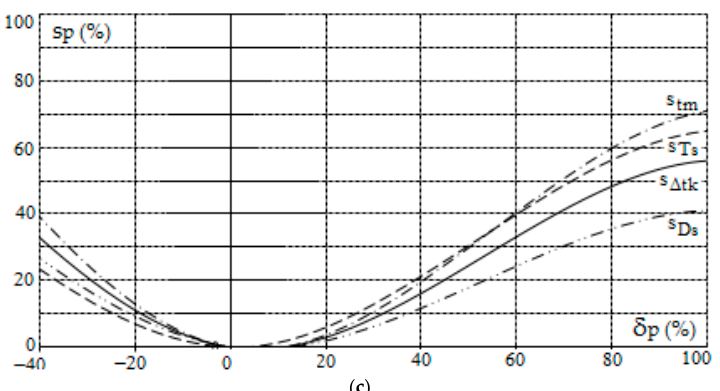
Figure 6. Sensitivity characteristics of the positional game control of the own object in good visibility at sea according to PG_gv algorithm as a function of: ( a ) absolute values of the information from sensors, ( b ) angular values of the information from sensors and ( c ) values of the control process parameters.